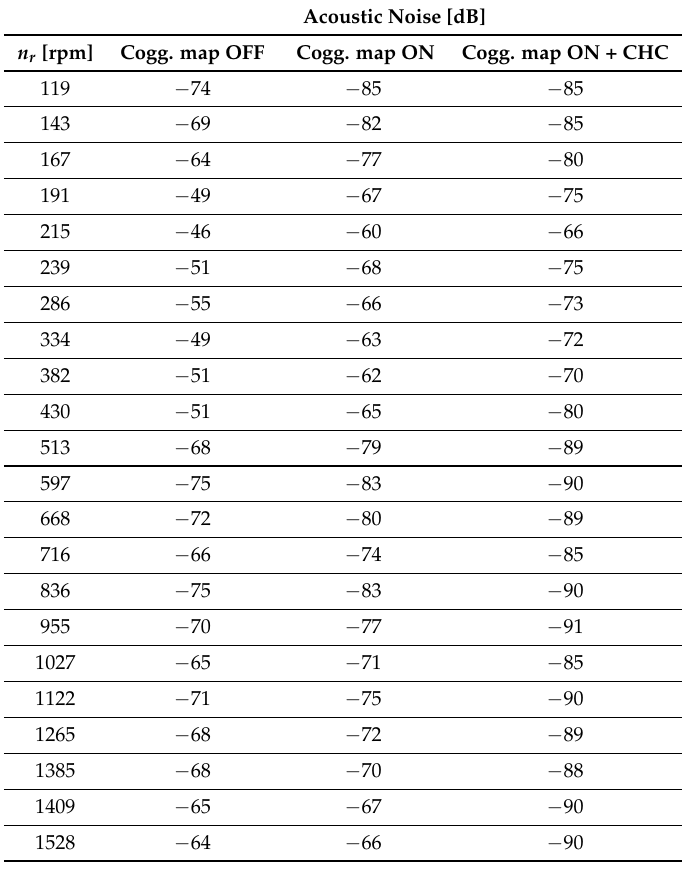
Table 3. Acoustic noise for 6 f e curve vs. mechanical speed n r